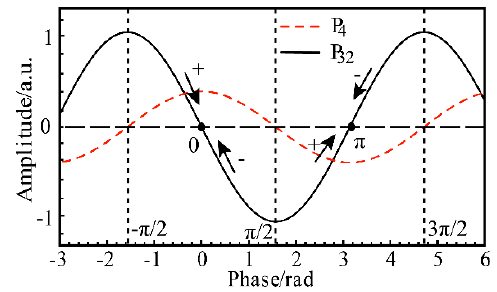
Figure 4. The schematic diagram of judging the direction of the phase compensation.